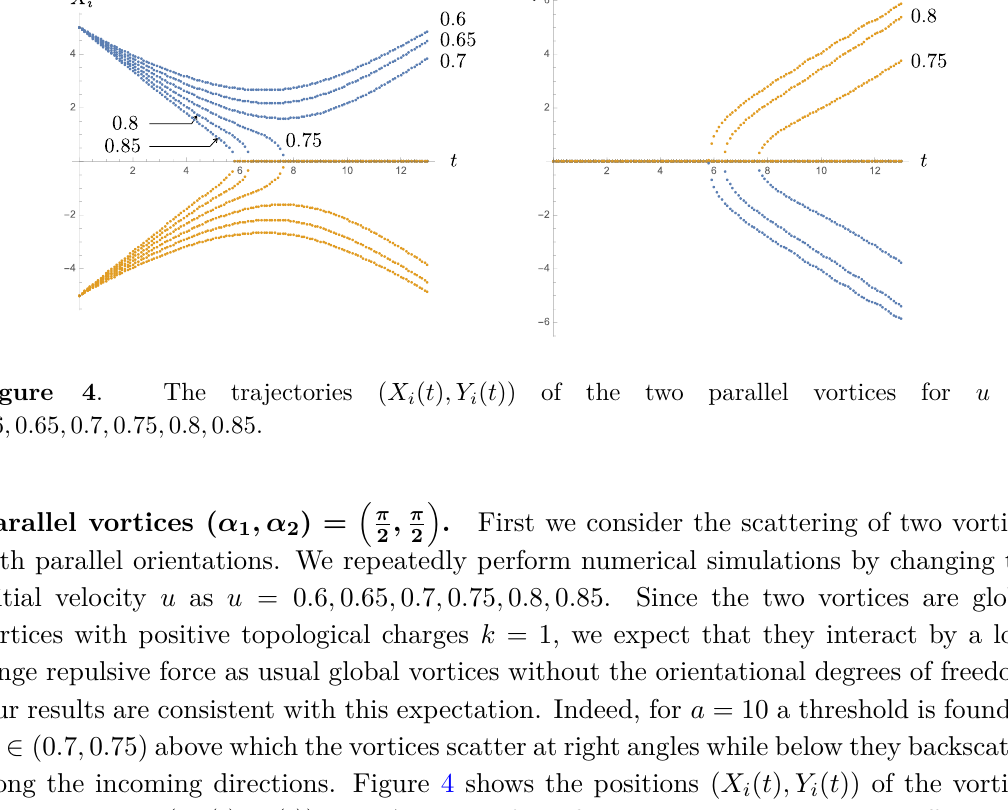
(cid:16) (cid:17) π , α ) = , π 1 2 2 2